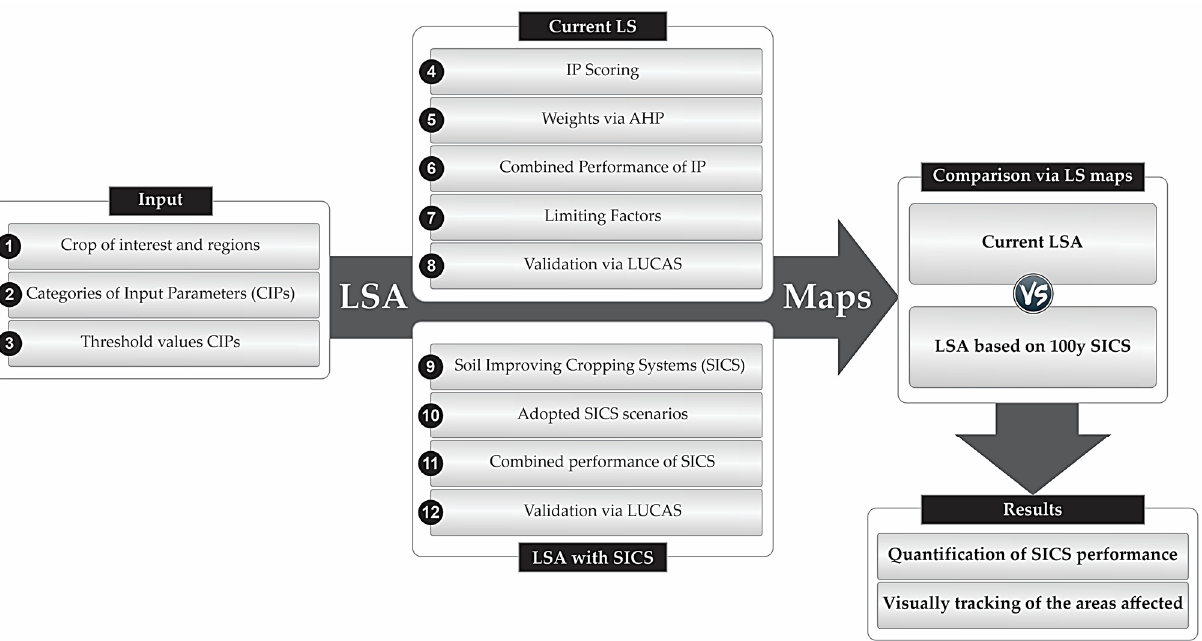
Figure 1. Steps (1–12) for using LSA as a tool to evaluate the level of current land suitability com- pared with future SICS. with future